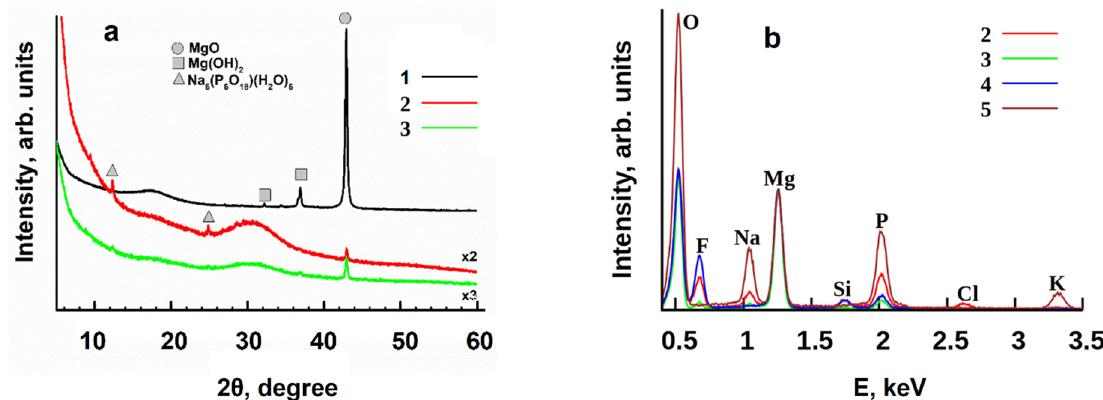
Figure 3. X-ray diffraction patterns ( a ) and EDS spectra ( b ) for the superhydrophobic samples before contact with biological liquids (1) and after 48 h of immersion in dispersions of K. pneumoniae (2), P. Aeruginosa (3), or PBS without bacteria (4). The EDS spectrum (5) was measured for bundles of microrods (such as those in Figure 1g,h), and was characteristic of microrods formed in both PBS dispersions studied, as well in PBS without bacteria.